Question: What visual encoding does this figure use to show its data?
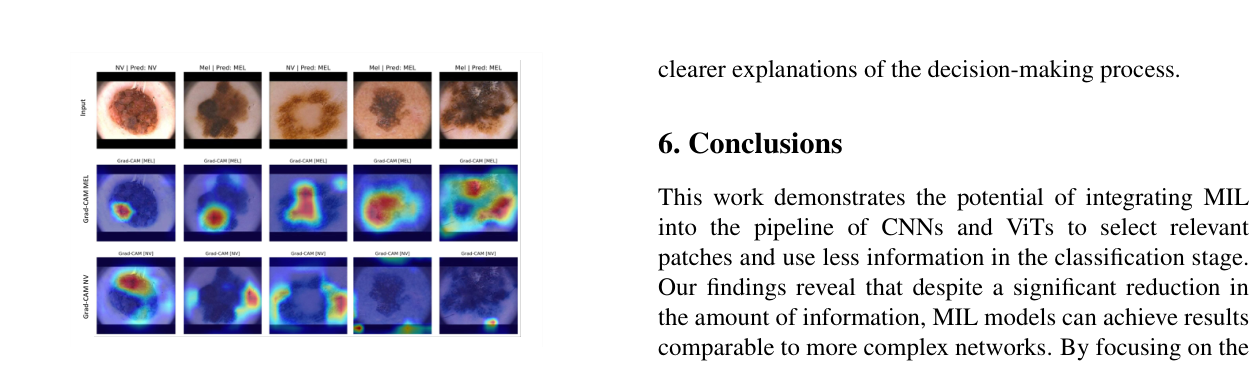
Answer: heatmap